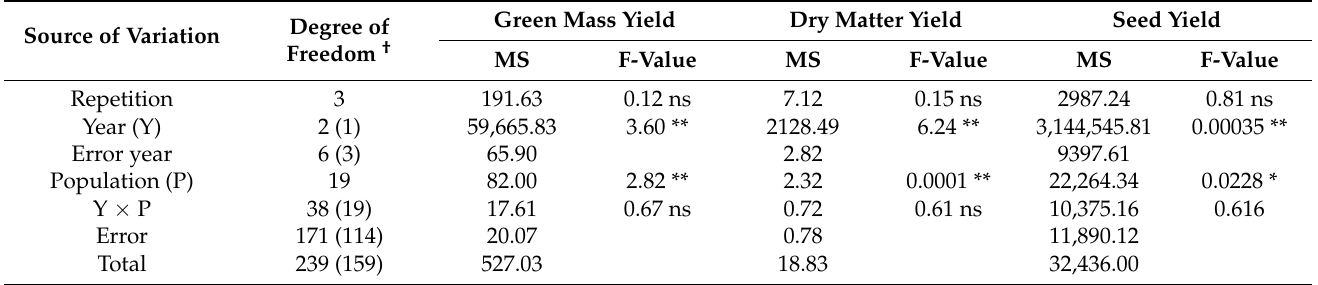
Table 1. Results of two-way ANOVA for analyzed traits of 20 alfalfa experimental populations/cultivar.